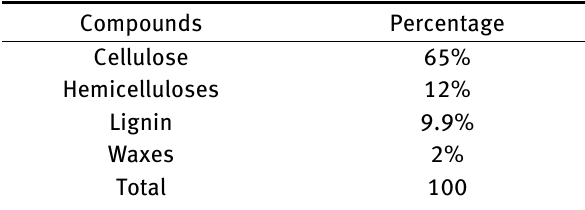
Table 8: Chemical composition of sisal fiber